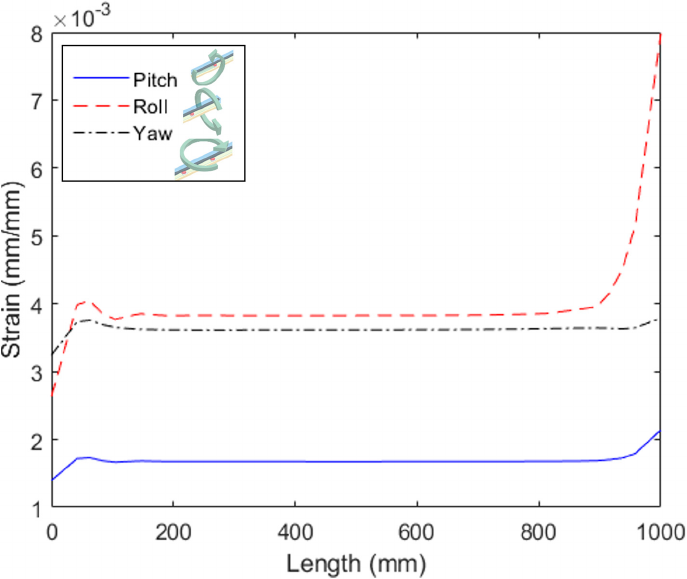
Figure 4. Numerical simulation of Configuration 1 subjected to momentums around each axis.